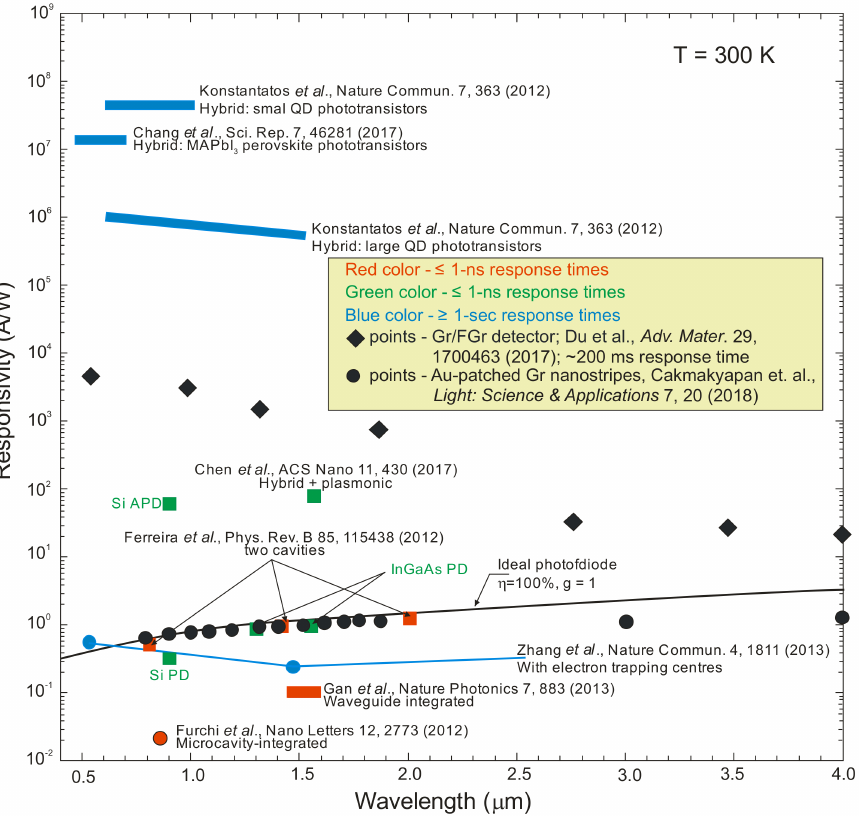
Figure 15. The graphene-based photodetectors spectral responsivity compared with commercial detectors. Black line presents spectral responsivity for ideal photodiode with 100% QE and g = 1. Red and green colors correspond to ≤ 1 ns, while the blue color ≥ 1 second response times. The graphene detectors are labelled with proper reference and brief description. The commercial photodiodes are marked in green (adapted after reference